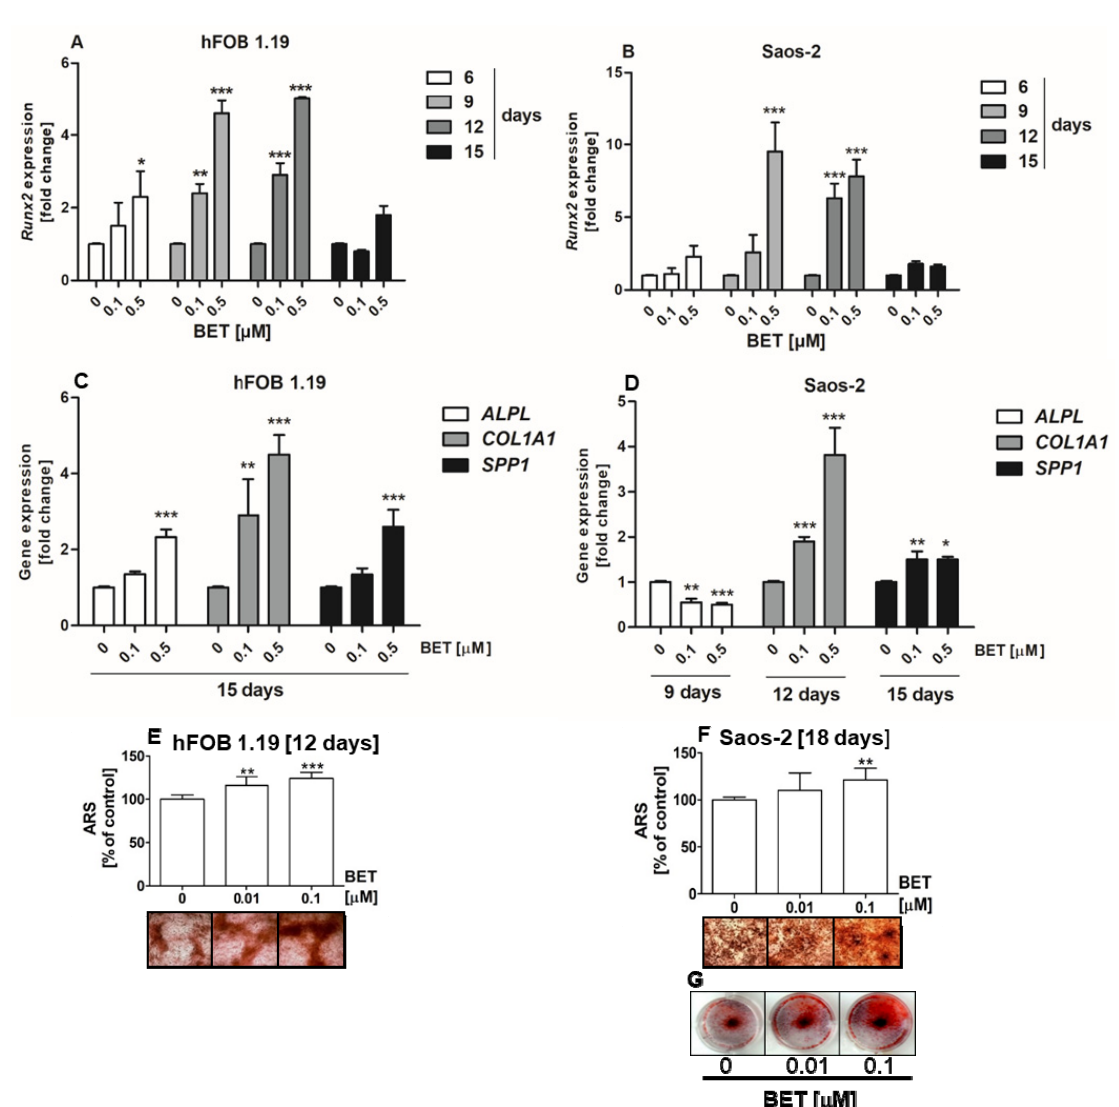
Figure 4. Effect of BET on the expression of RUNX2 and other differentiation marker genes, and the levels of mineralization in osteoblasts in osteoinductive conditions. The osteoblasts were cultured in an osteoinductive medium supplemented with 0.01, 0.1, or 0.5 μ M of BET or without the compound (control). The expression of the RUNX2 gene was determined in the hFOB 1.19 ( A ) and Saos-2 ( B ) cells by RT-qPCR after the indicated period of culture. The expression of osteogenic genes ALPL , COLIA1 (type I collagen), and SPP1 (OPN) was determined in the hFOB 1.19 ( C ) and Saos-2 ( D ) cells by RT-qPCR after the indicated period of culture. The levels of calcium deposited in the extracellular matrix were determined in 24-well plates using Alizarin Red S staining. Representative micrographs (40 × ) of stained cultures and mean levels of ARS extracted from the hFOB 1.19 ( E ) and Saos-2 ( F ) cultures. Representative photographs of stained Saos-2 cultures ( G ). Mean ± SD from three independent experiments; * p < 0.05, ** p < 0.01, *** p < 0.001 in comparison to the control, one-way ANOVA with post hoc Dunnett’s test.